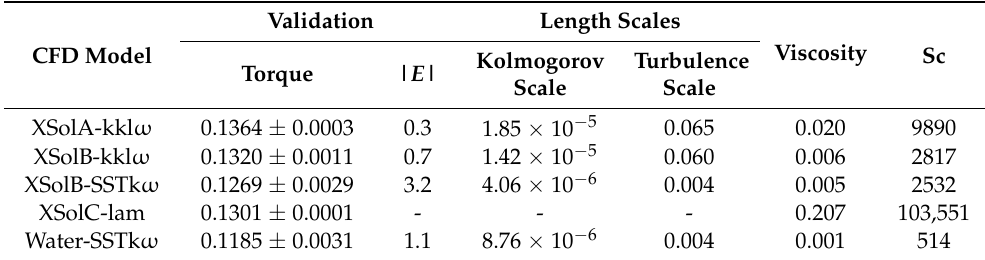
XSolC-lam 0.1301 ± 0.0001 - -